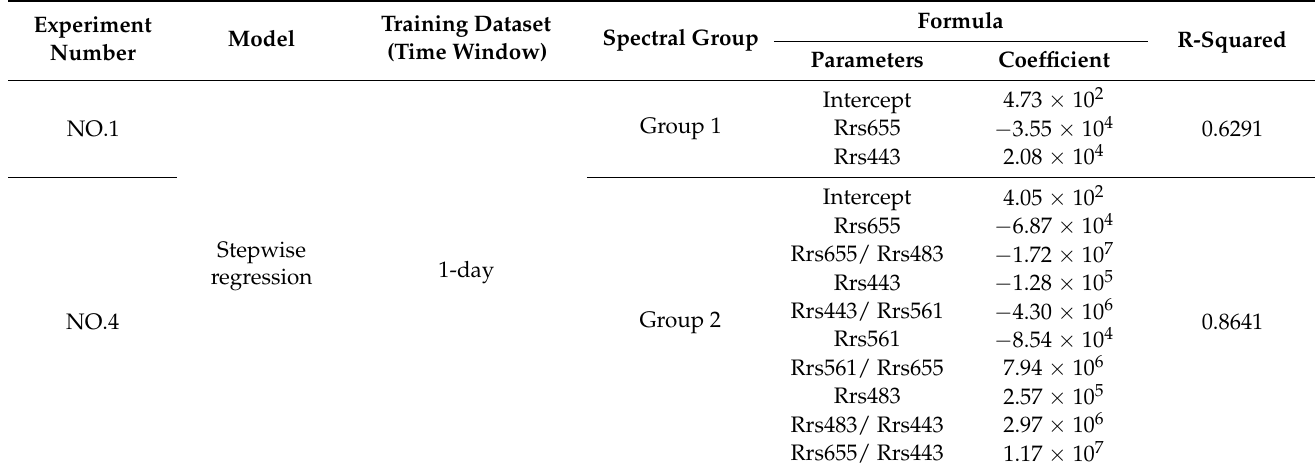
Table 4. The optimal models of stepwise regression correspond to two groups of spectral variables and their related details. Group 1 represents the spectral variables that use a single band or band combination. Group 2 represents the spectral variables that use band combination and band ratio arrangement. The experiment number corresponds to Table